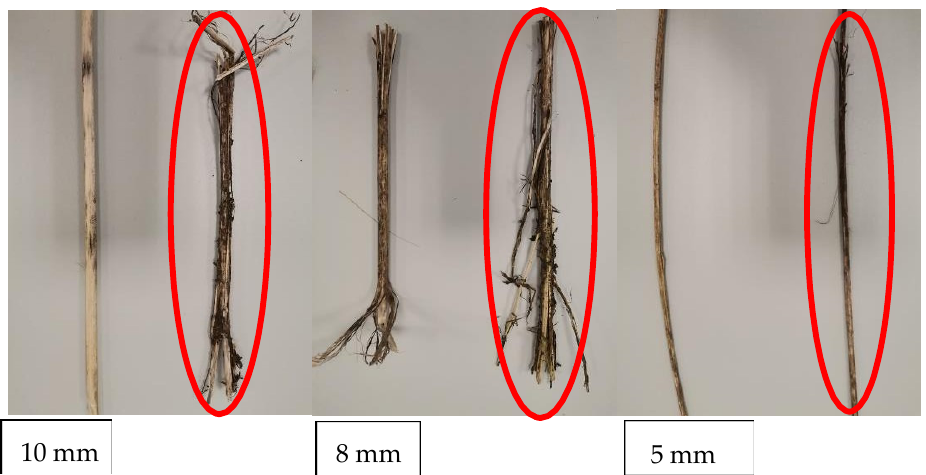
Figure 3. Visual differences between rolled and unrolled cannabis residues. Rolled cannabis remains are marked in red.